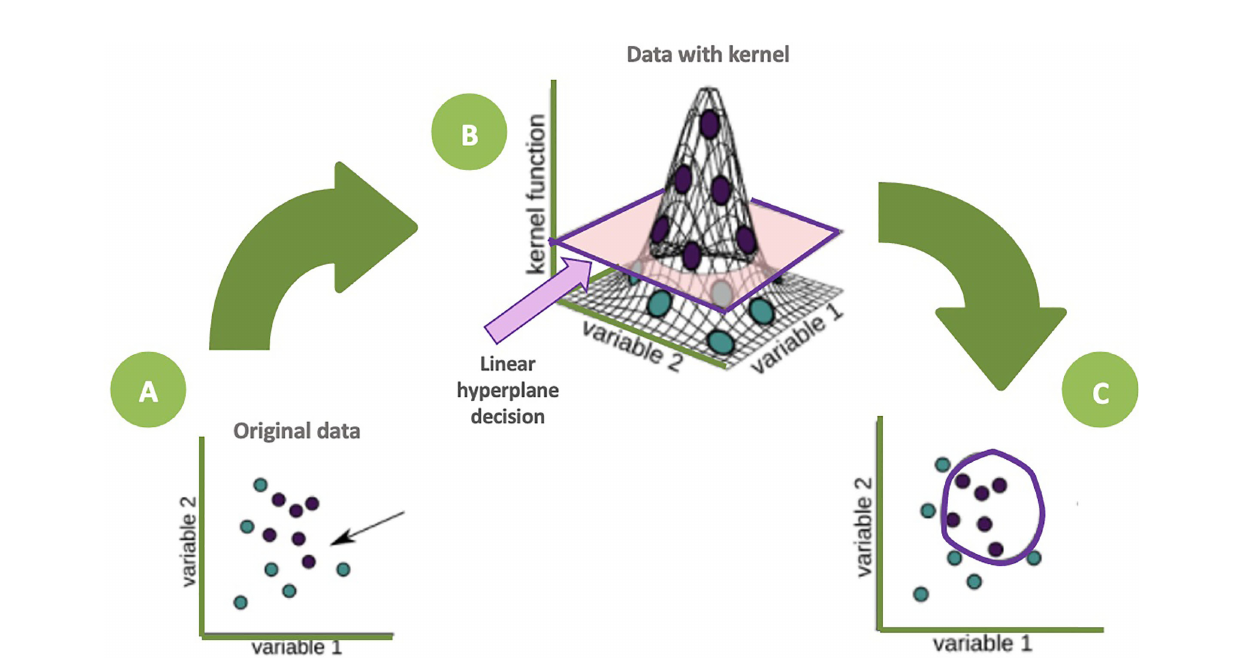
FIGURE 3 | Schematic representation of a SVM algorithm. The dots represent individuals according to two variables (A) , no linear classi fi cation function seems obvious. The kernel function allows a representation of the individuals in a 3rd dimension allowing the highlighting of a hyperplane which classi fi es the individuals in two groups (B) . The individuals are then projected into the initial dimensional space (C) with a non-linear separator (purple